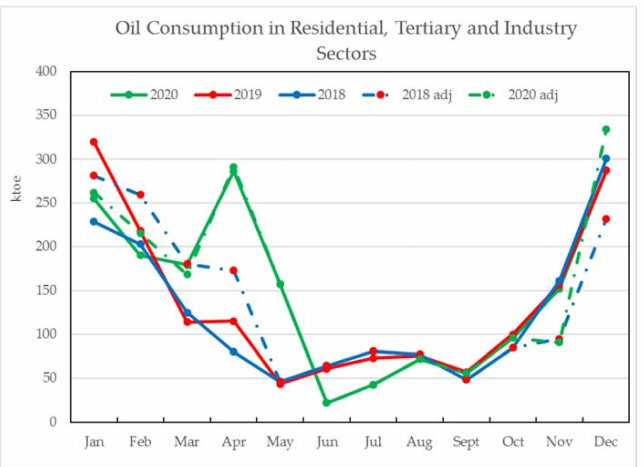
Figure 9. Comparison of heating oil consumption, actual and adjusted for temperature variation,